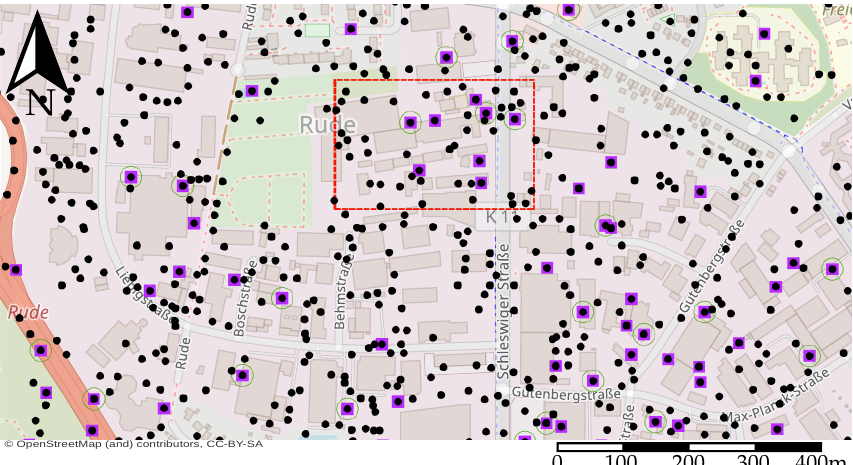
Figure 4. Identified subarea center points for extraction of the case area with 10cm (black dots), 30cm (magenta squares) and 50cm (green circles) thresholds, respectively.